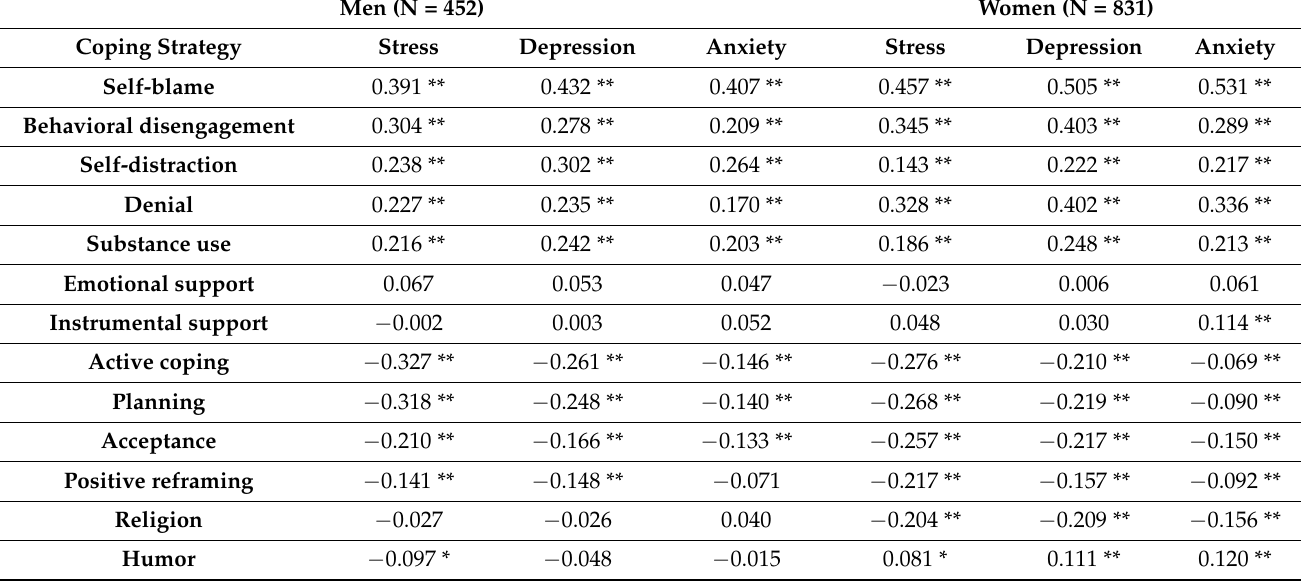
Table 3. Correlation between coping strategies and stress, depression, and anxiety by sex.